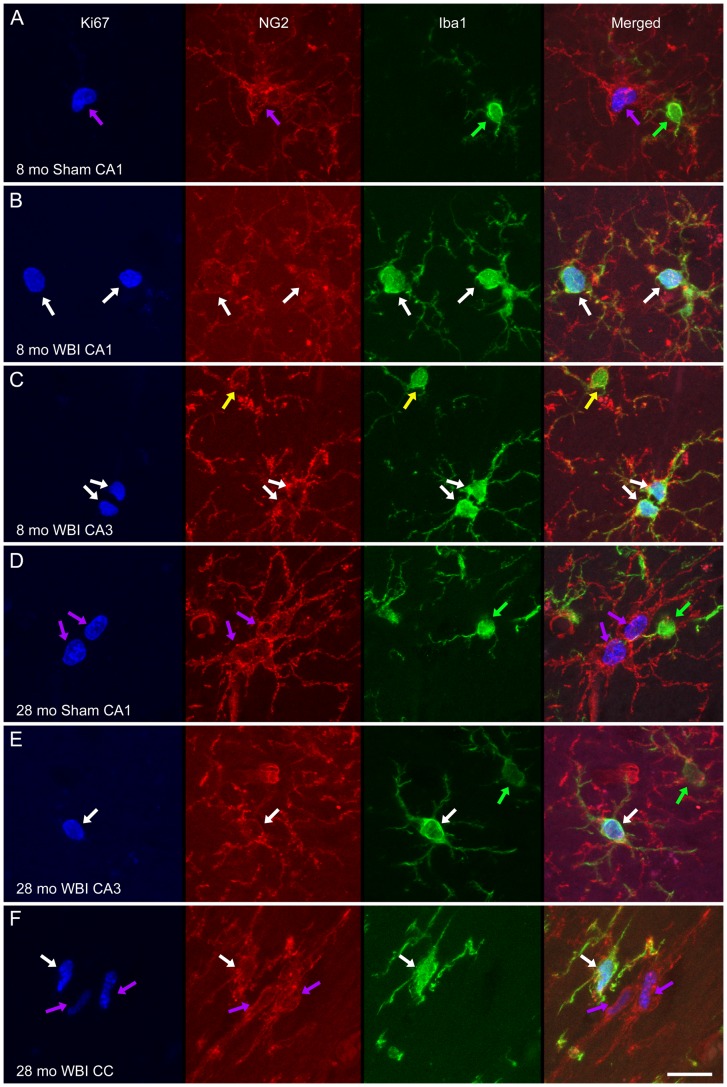
Phenotype analysis of proliferating non-microglial cells.Representative examples of triple-IF labeling for Ki67 (blue), NG2 (red), and Iba1 (green) are shown from animals of the indicated ages and conditions. For each example an image stack was collected (Z step = 0.5 µm) and projected to a single image plane (maximum intensity function). Dividing microglia (Ki67+/Iba1+/NG2+) are indicated by white arrows. Among the Iba1+ microglia that were not dividing, some co-expressed NG2 (yellow arrows) while others did not (green arrows), although NG2+ process often were located in close approximation to the latter. The dividing cells that did not express Iba1 were NG2+ (purple arrows). Scale bar = 15 µm.